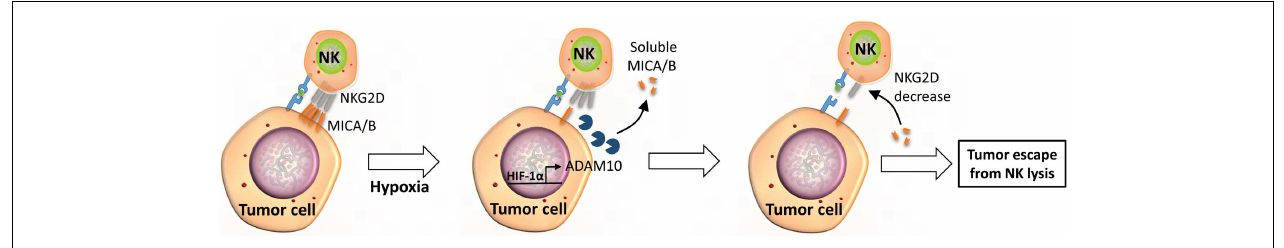
ligands on the surface of tumor cells and soluble MICA/B downregulates the expression of NKG2D on the surface of NK cells, leading to tumor escape from NK-mediated